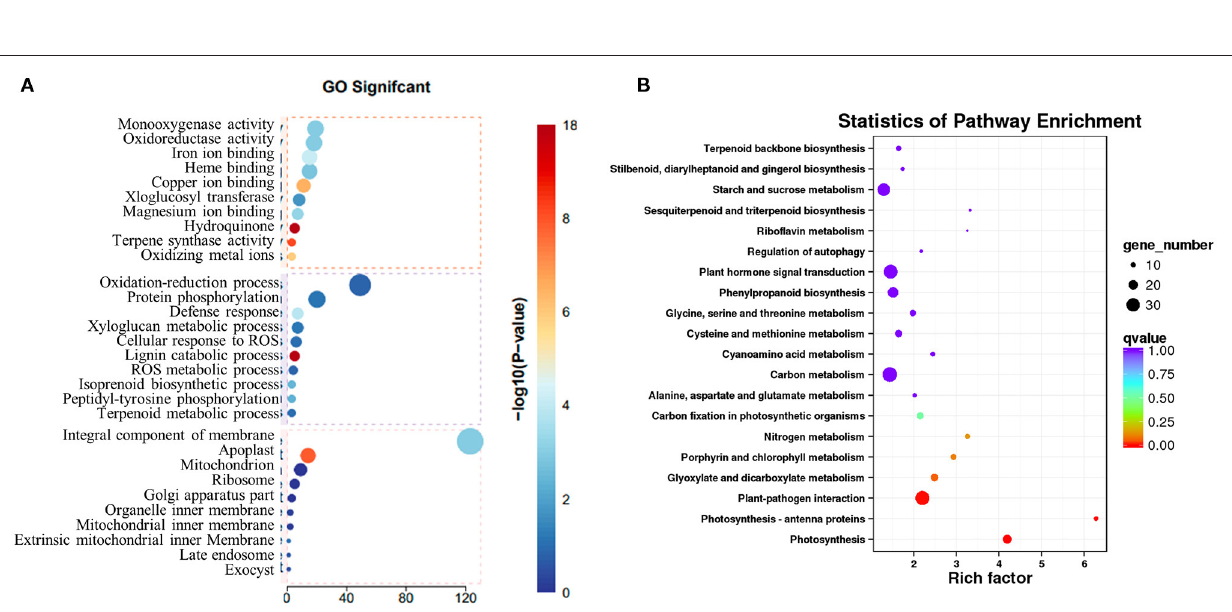
FIGURE 4 | Transcriptomic analysis of Salvia miltiorrhiza with low concentration copper treatment. (A) Two-month-old S. miltiorrhiza was treated with CuSO4.5H 2 O (5 µ M) for 5 days, following which mRNA was extracted from roots and subjected to transcriptomic analysis. (A) Differentially expressed genes were identified by comparing gene expression in copper treated vs . untreated samples. Function of identified significantly changed genes was analyzed using the gene ontology (GO) database. (B) Pathway mapping of significantly changed genes was performed using the Kyoto Encyclopedia of Genes and Genomes database (http://www.genome.